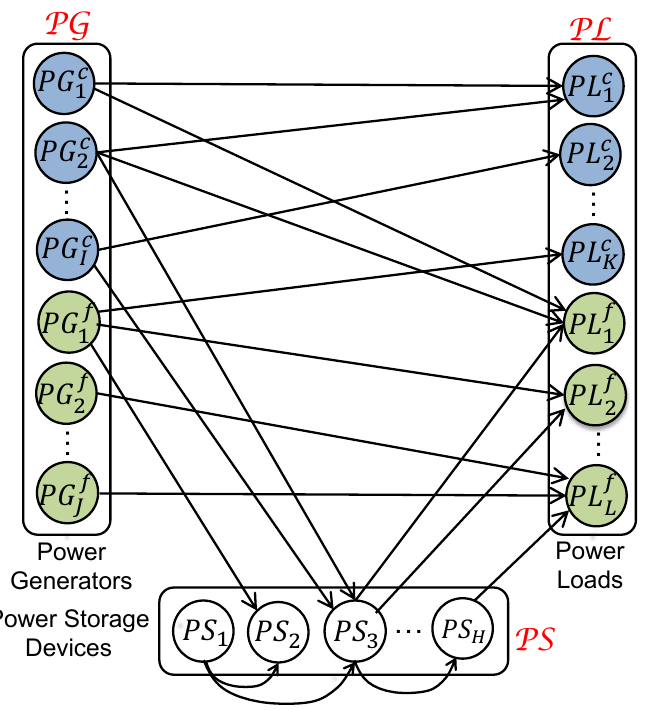
Figure 3. Presentation of power generators, power loads, power storage devices, and connections between power devices